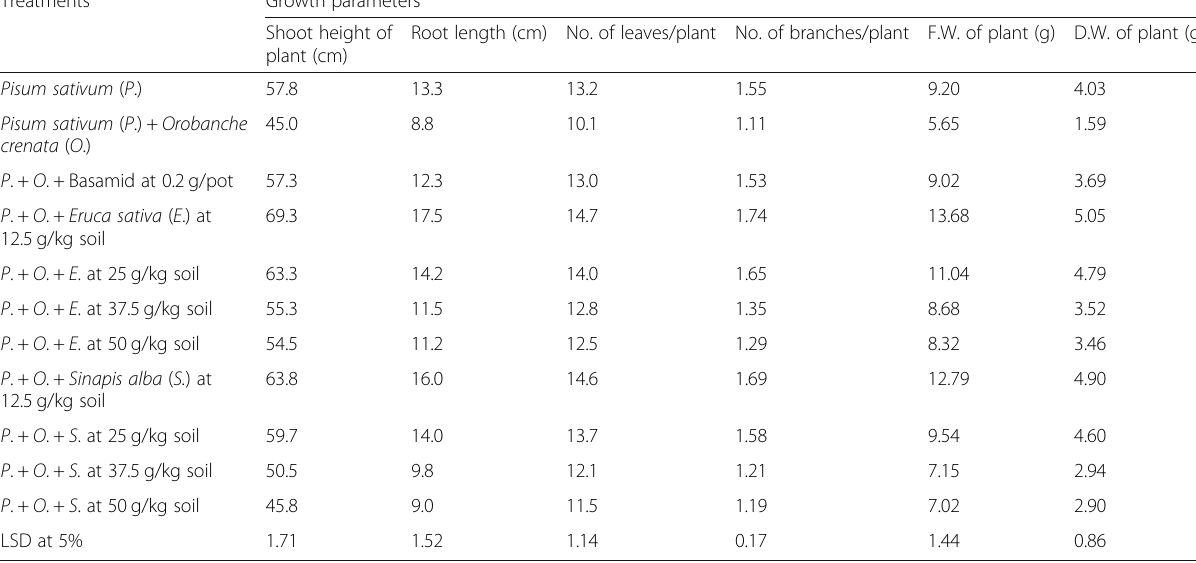
Table 3 Effect of different rates of both Eruca sativa and Sinapis alba seed powder and herbicide Basamid on growth parameters of Pisum sativum at 55 days after sowing (combined analysis of two seasons) Treatments Growth parameters Shoot height of Root length (cm) No. of leaves/plant No. of branches/plant F.W. of plant (g) D.W. of plant (g) plant (cm) Pisum sativum ( P .)